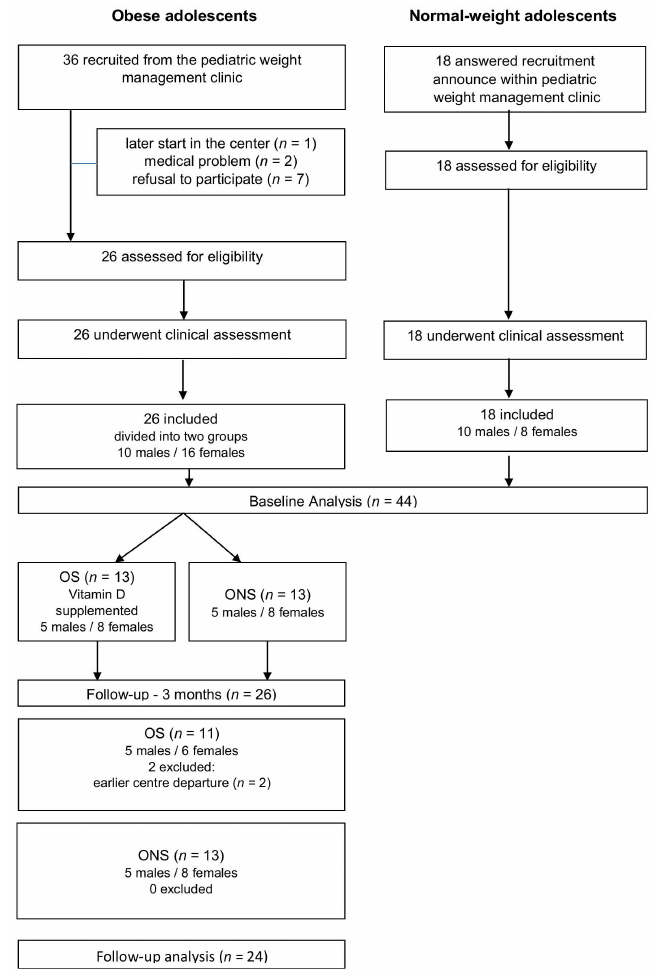
Figure 1. Flow chart of adolescent participants. OS: obese participants receiving vitamin D supple- ments; ONS: obese participants not receiving vitamin D